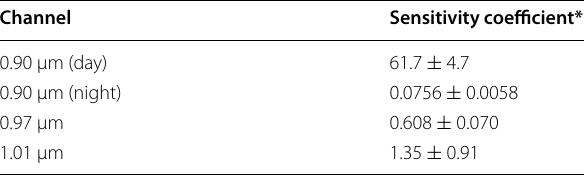
Table 4 Sensitivity coefficients for the four channels of the 1‑μm camera